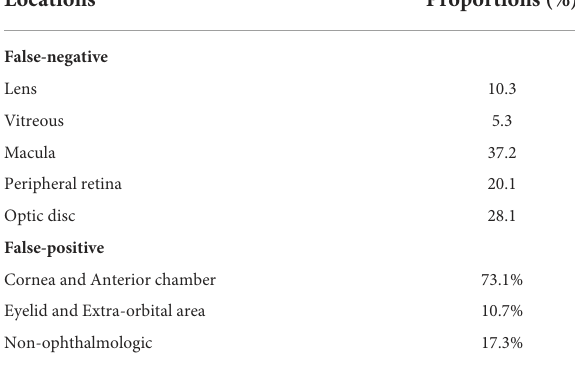
TABLE 3 Locations of clinically significant lesions in false-negative and false-positive categories with overall test